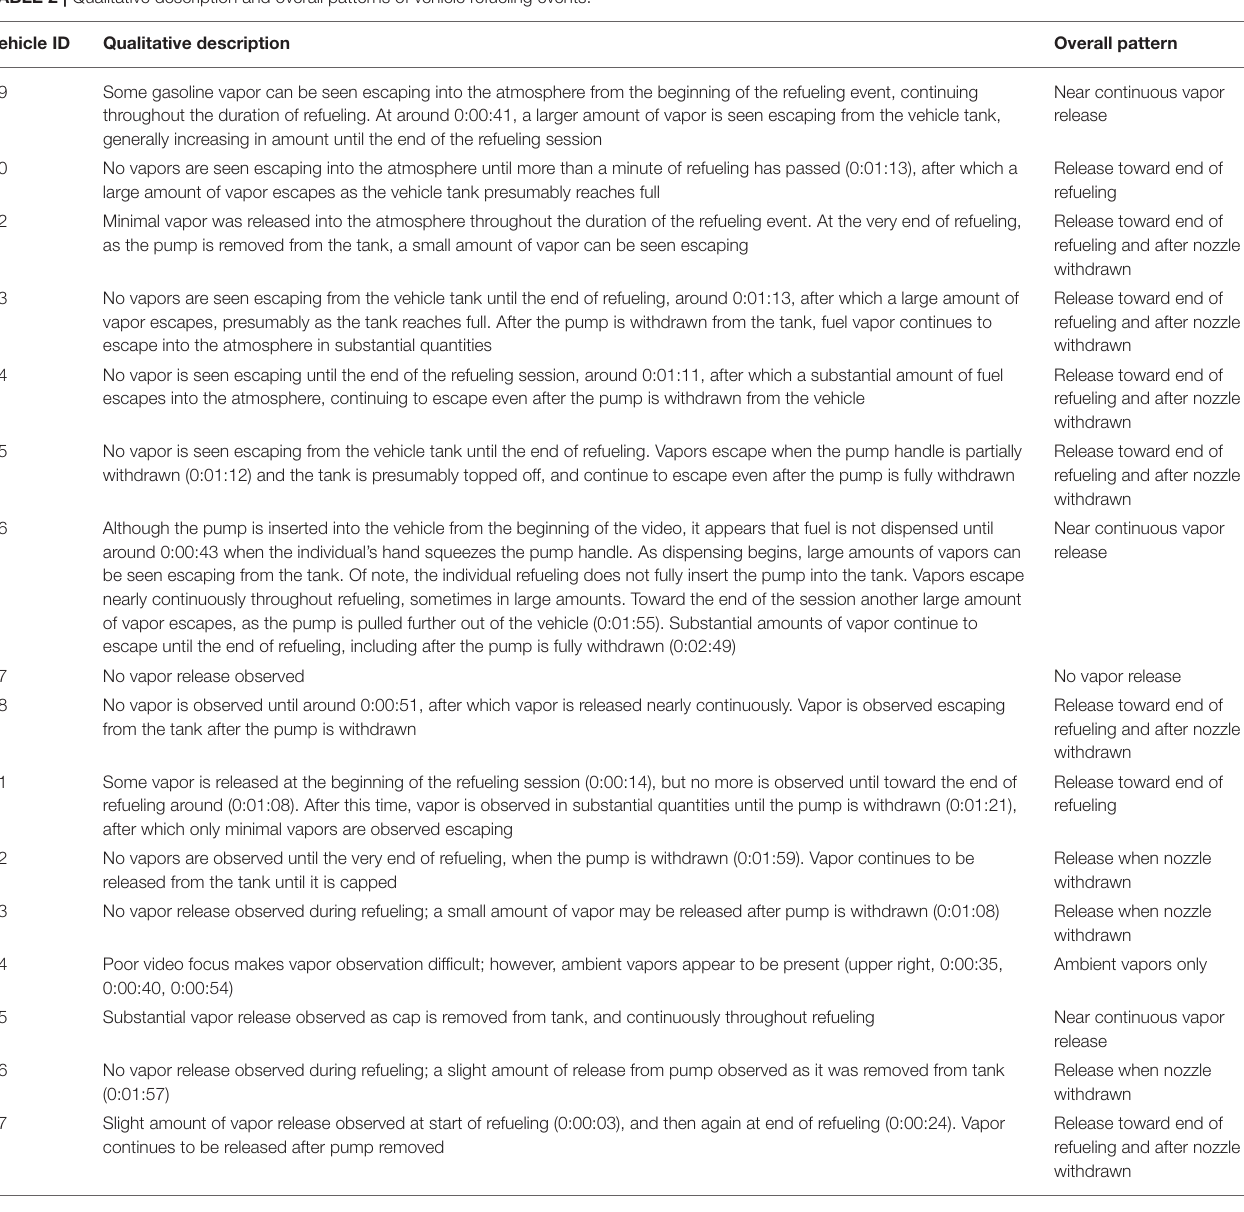
TABLE 2 | Qualitative description and overall patterns of vehicle refueling events. Vehicle